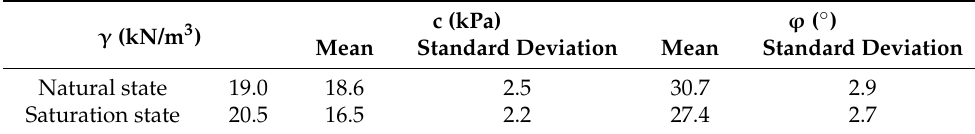
Table 5. Shangfang landslide stability calculation parameters.